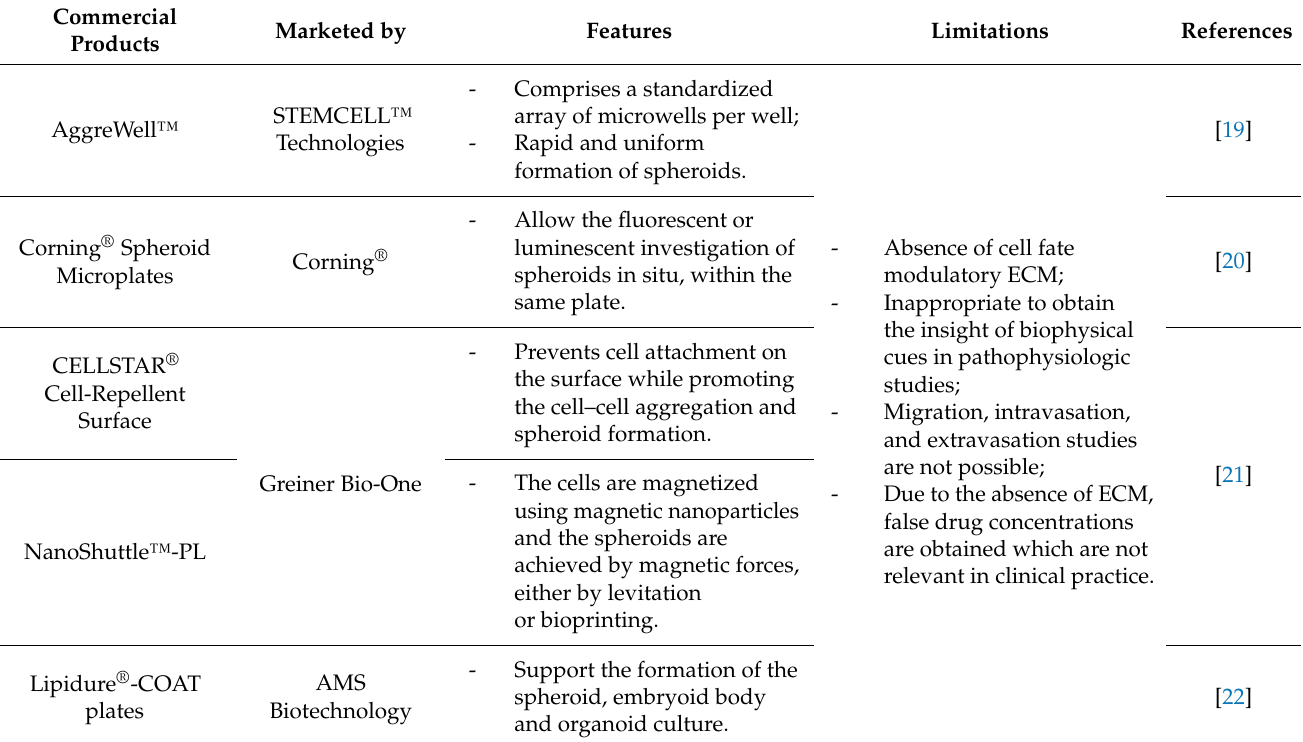
Table 1. Different types of 3D culture plates and surfaces commercially